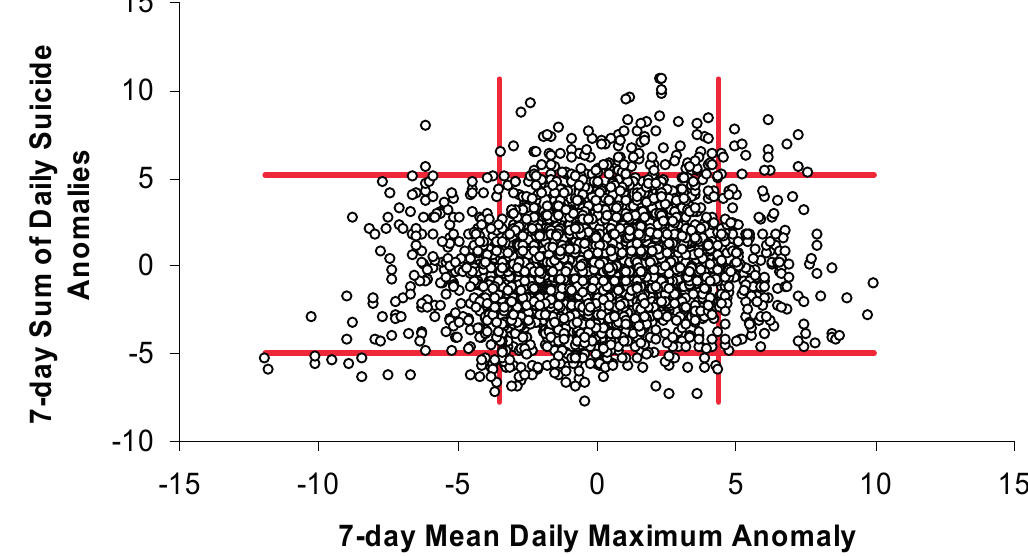
Figure 6. Weekly suicide anomalies plotted against weekly anomalies of greatest absolute daily departures from climatological normal temperature (maximum or minimum) for selected months (Jan, Jul, Aug, Sep) in Toronto. Red bars help to identify temperature-anomaly thresholds that may improve prediction of suicide